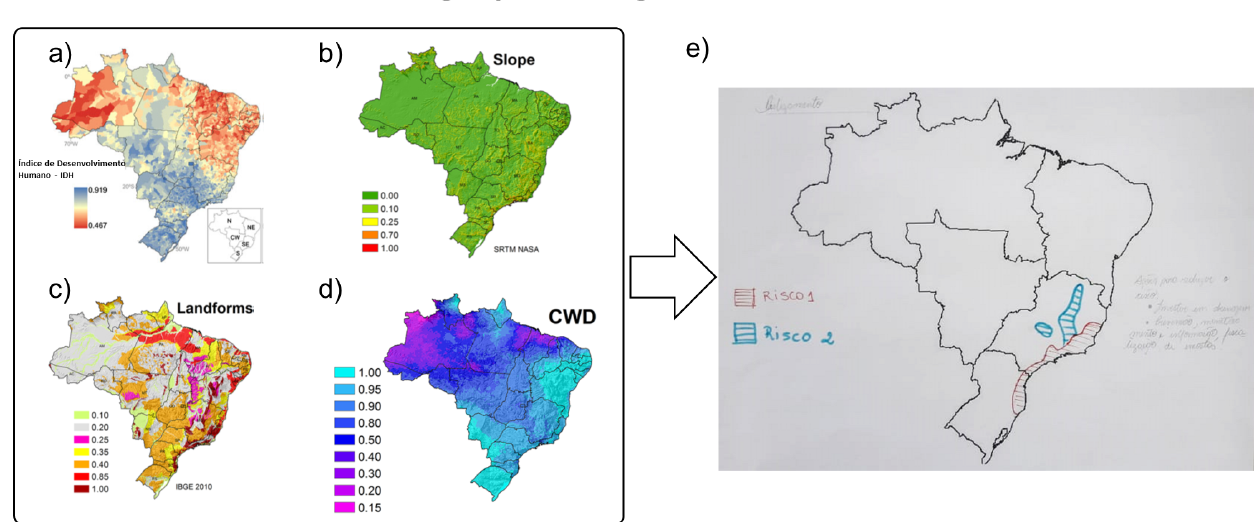
Figure A6. Package of maps used in the second training for mapping climate risk associated with landslides. The maps illustrate (a) Human Development Index (HDI; Torres et al., 2012), (b) slope (Debortoli et al., 2017), (c) landforms (Debortoli et al., 2017), (d) consecutive wet days (CWD; Debortoli et al., 2017), and (e) the climate risk map drawn by the participants.